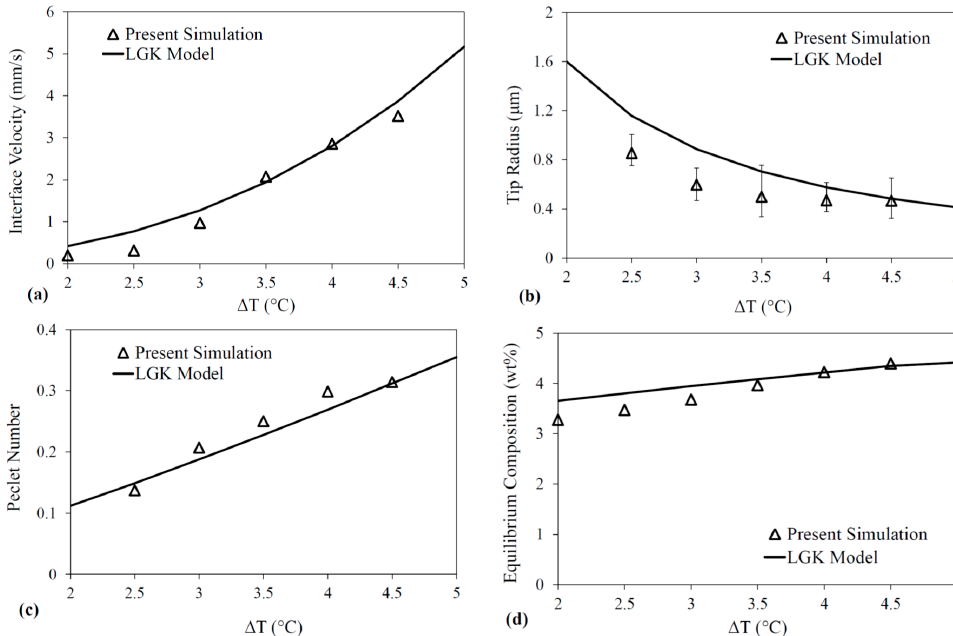
Figure 4. Comparison between the results of the present model and the Lipton-Glicksman-Kurz (LGK) analytical model for steady state tip characteristics: ( a ) average tip velocity; ( b ) tip radius; ( c ) Peclet number; and ( d ) interface equilibrium liquid composition.